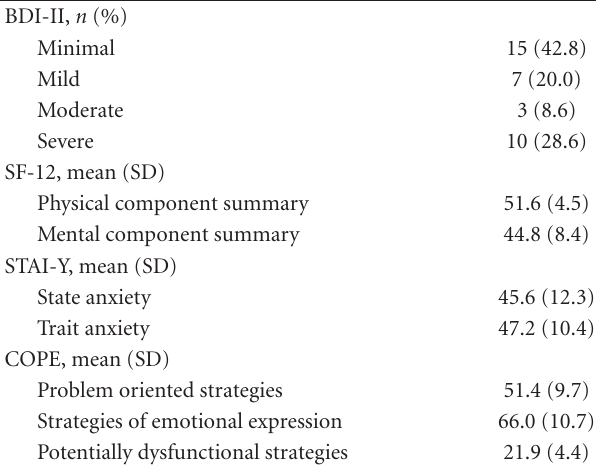
Table 4: Scores of psychological assessments of caregivers of chil- dren with